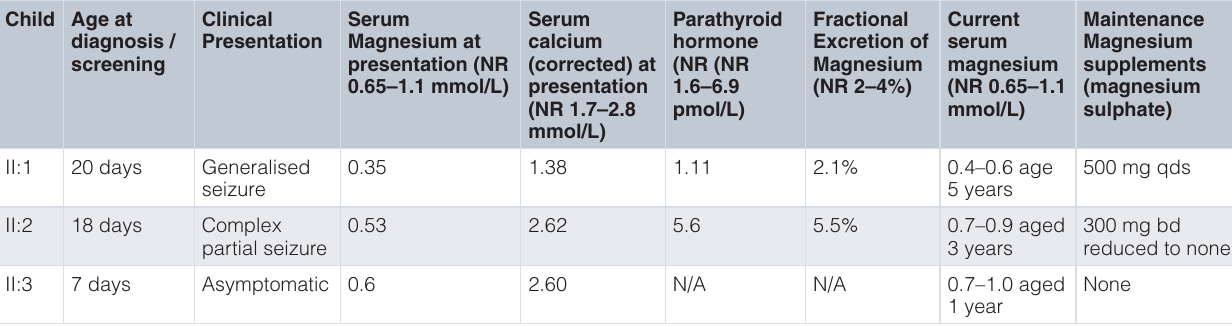
Table 1. Clinical and biochemical features of